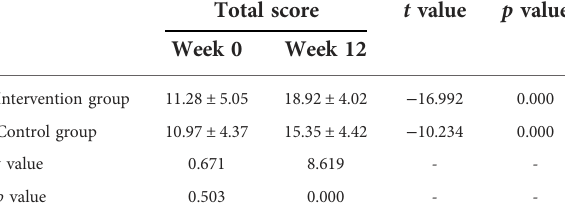
TABLE 2 Basic information and clinical characteristics of patients.